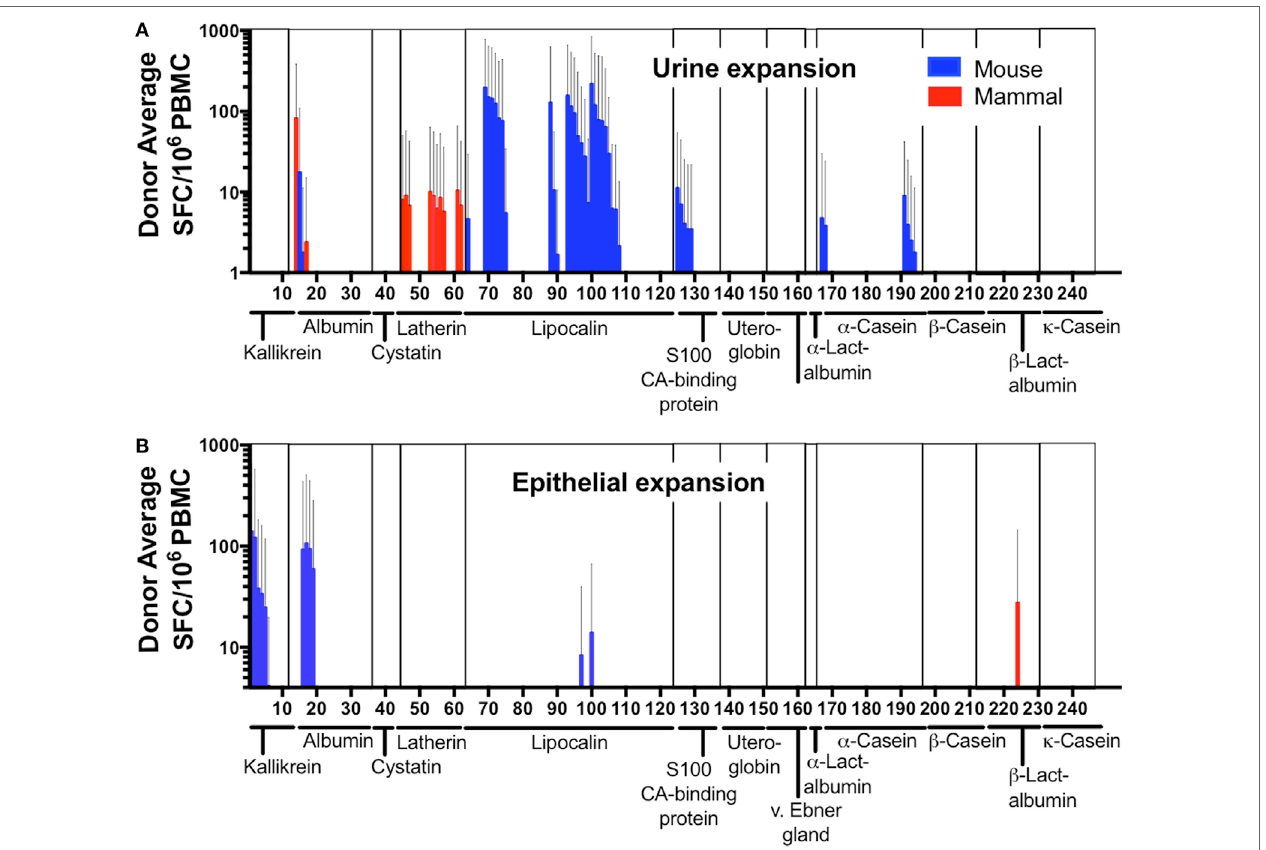
FigUre 3 | T cell reactivity against mammalian allergens and their murine homologs. Cytokine production (IL-5 + IFN γ ) was measured as spot forming cells by ELISPOT in response to mammalian-allergen-derived peptides and their homologous murine counterpart after expansion with (a) mouse urine or (b) epithelial extract. Allergen families are indicated along the x -axis. Error bars indicate